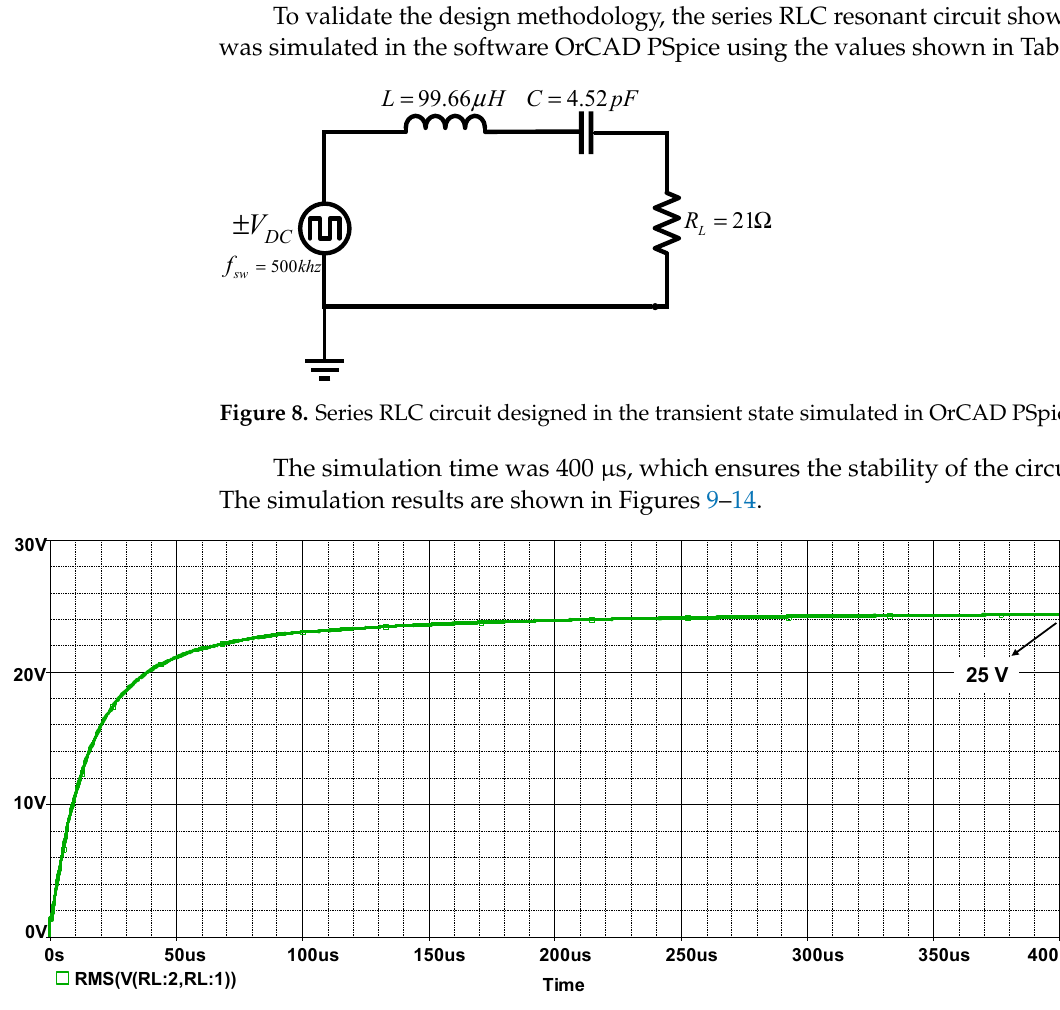
Figure 10. Average output power (P o ) at the load resistor. Figure 11. Current in the resonant tank.